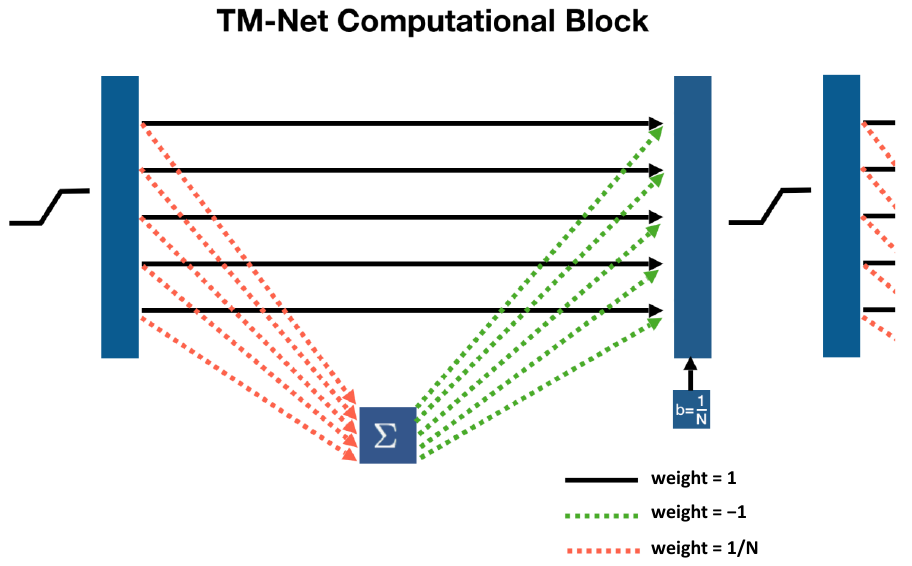
Figure 6. Graphical representation of a single layer in an N layer Tone-Mapping network(TM-Net). In this example, N =